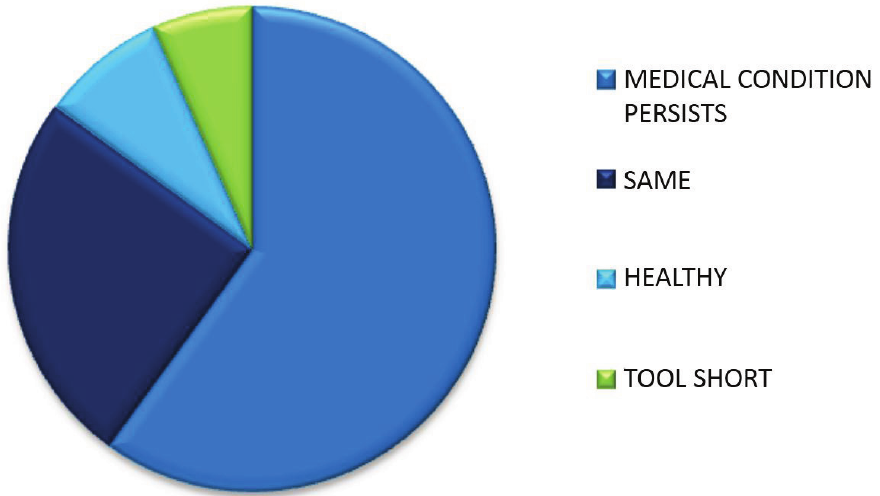
Figure 6. Proportion of reasons given by patients for feeling their health had not